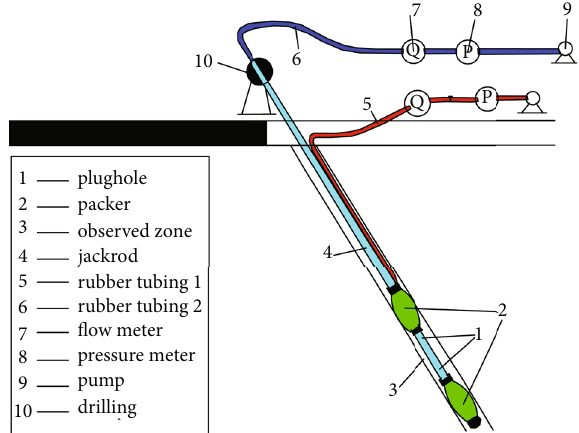
Figure 13: Schematic diagram of water injection in the damaged area of the mining fl